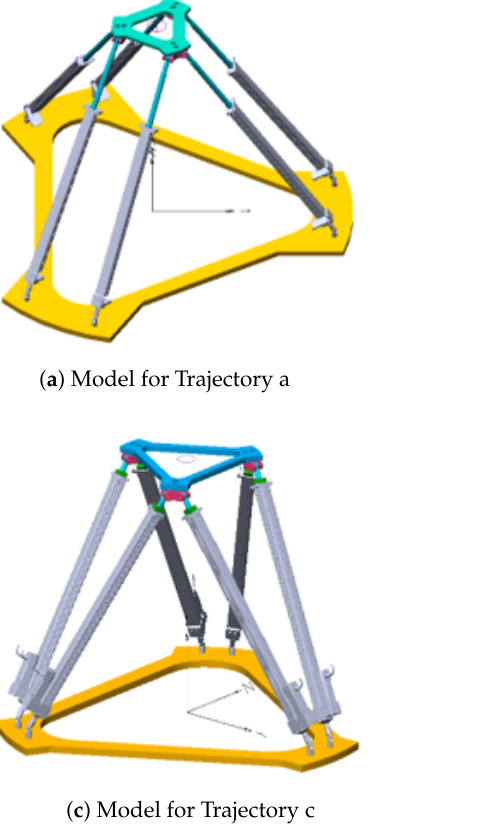
Figure 6. Results for dimensional synthesis based on target